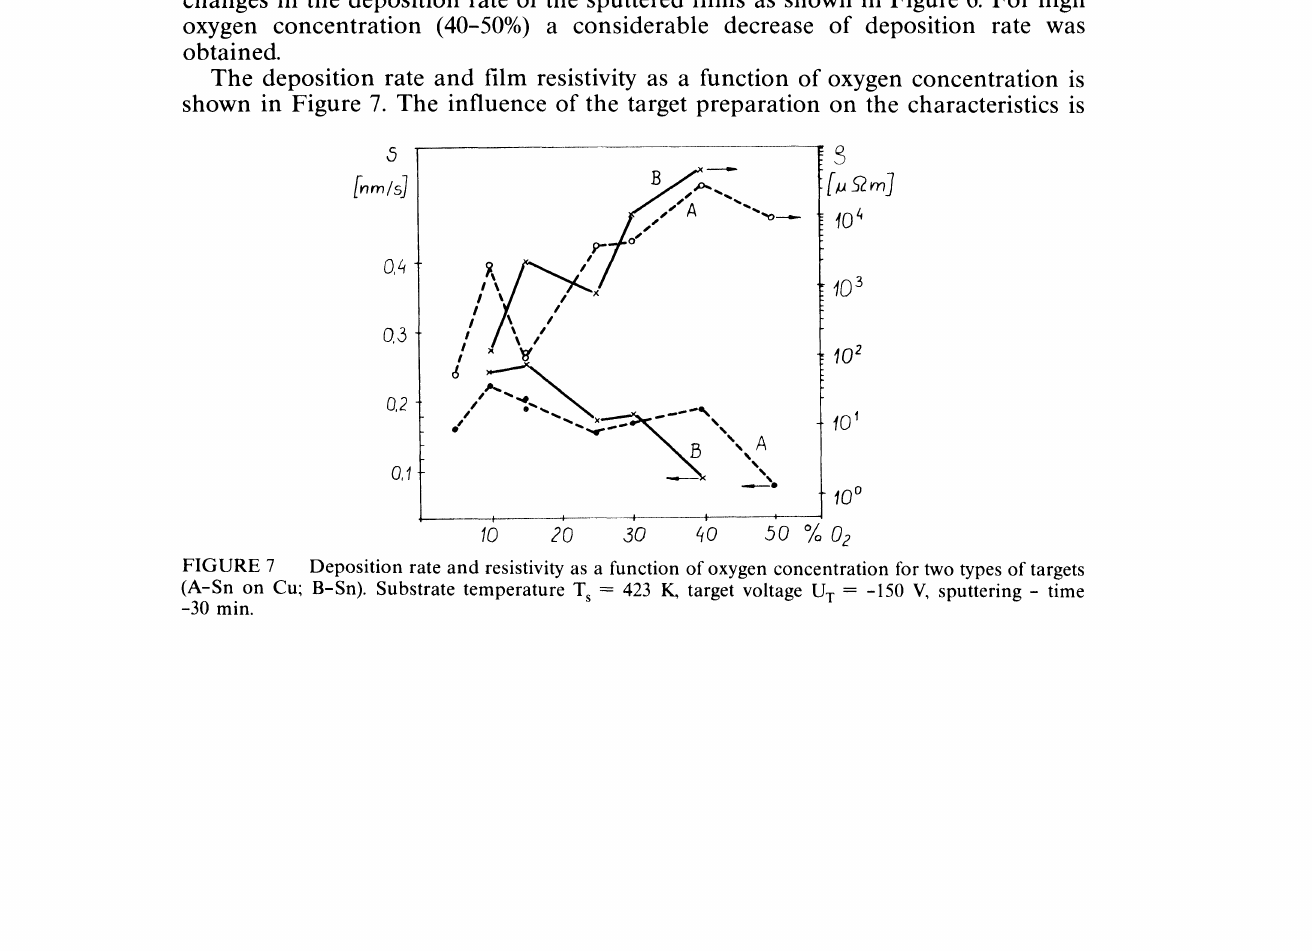
FIGURE 7 Deposition rate and resistivi as a function of oxygen concentration for o pes of targets (A-Sn on Cu; B-Sn). Substrate temperature T 423 target voltage U -30